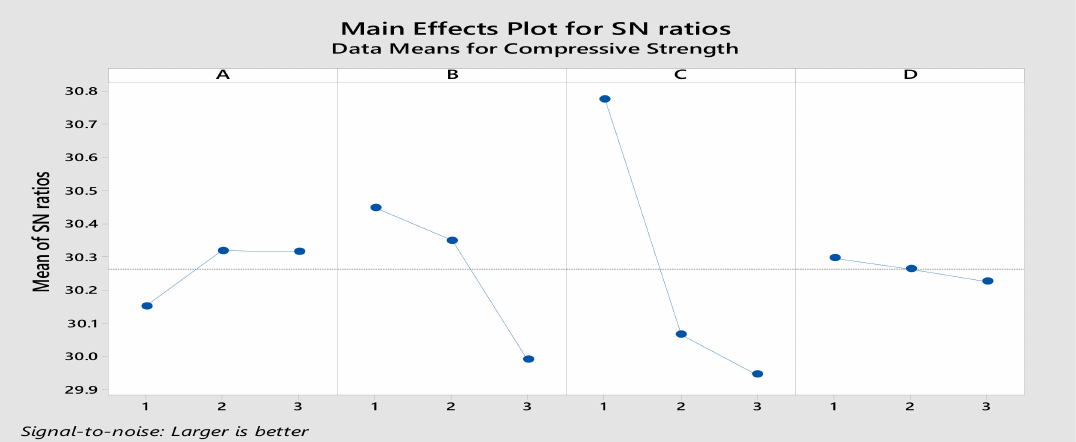
Figure 5. Main effects plot of SN ratios for compressive strength using the Taguchi method.